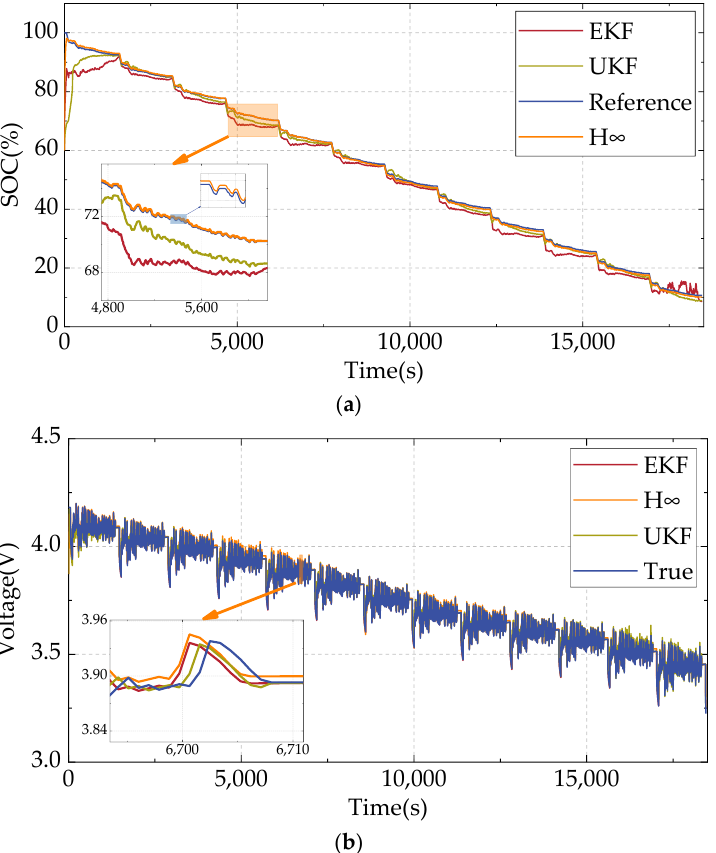
Figure 11. The results of SOC and voltage estimation using different methods under UDDS conditions: ( a ) SOC estimation results; ( b ) terminal estimation results.